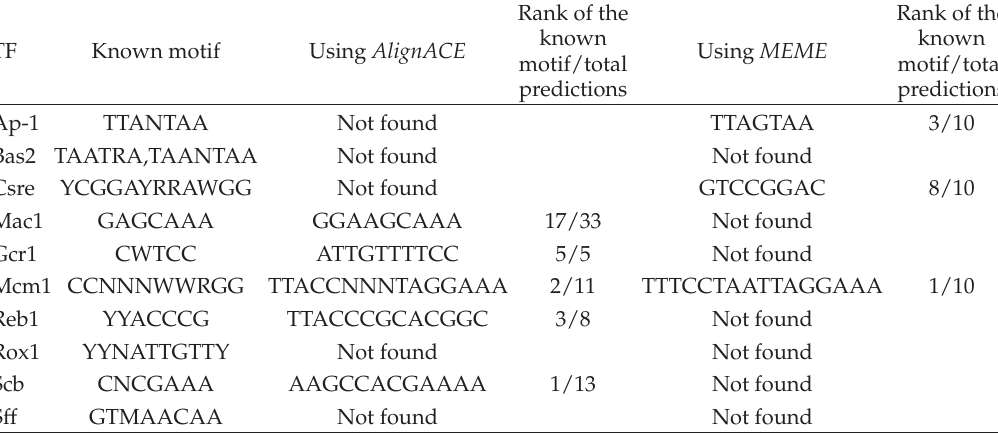
Table 5: The TFs whose known binding sites cannot be found using our method. The expected number of motifs predicted by MEME was set at